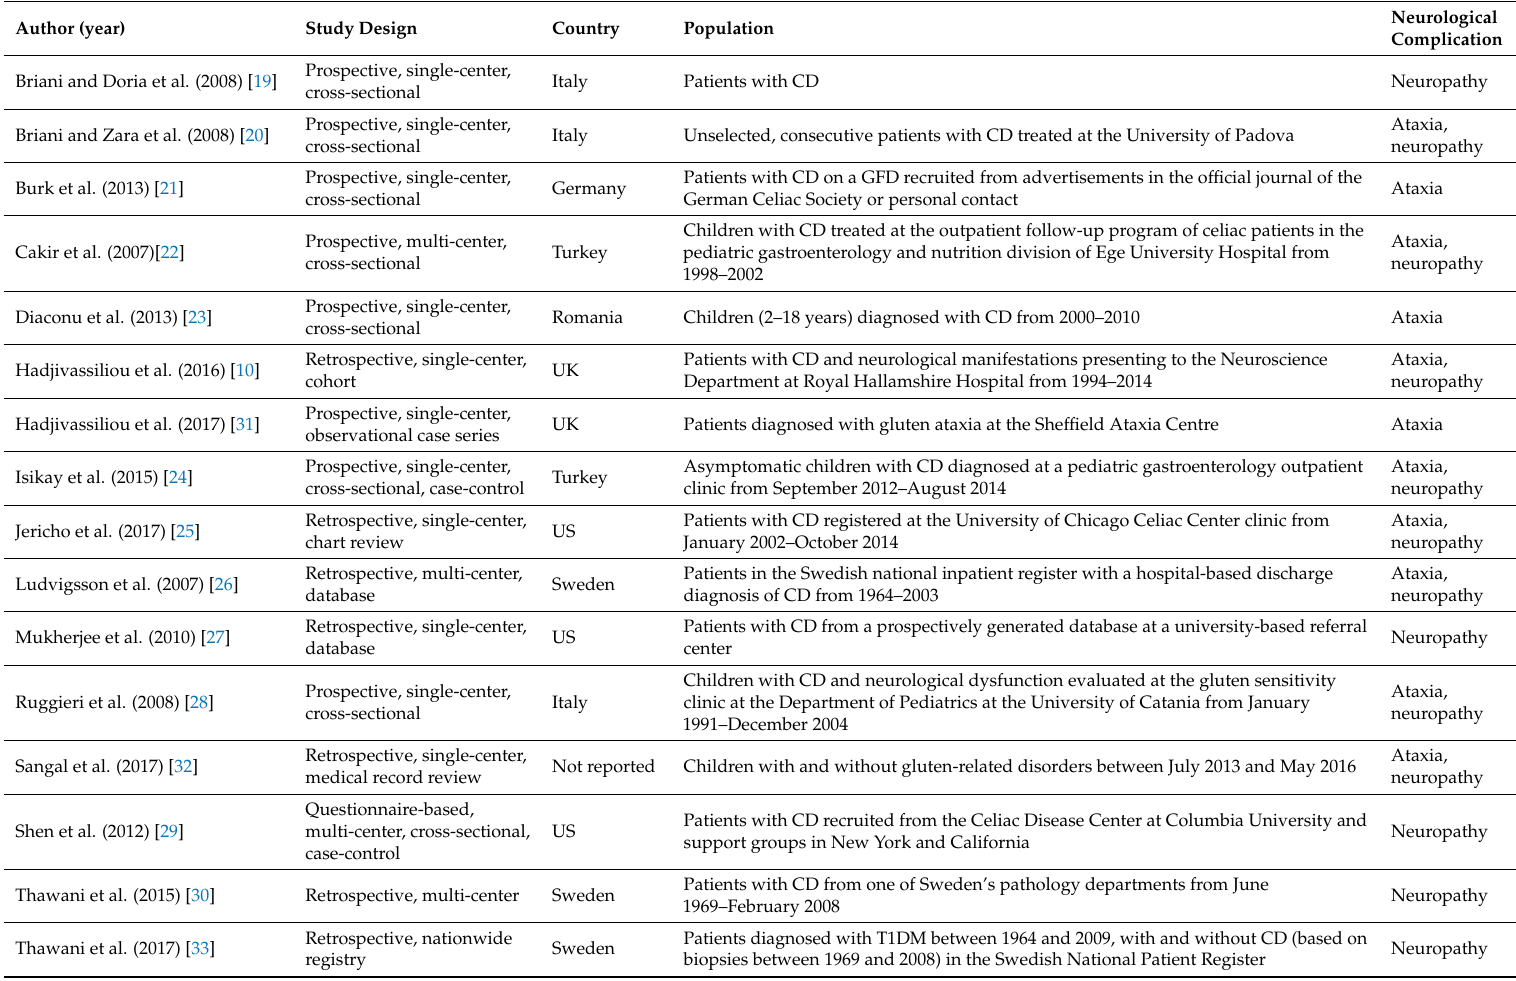
Table 3. Characteristics of Included